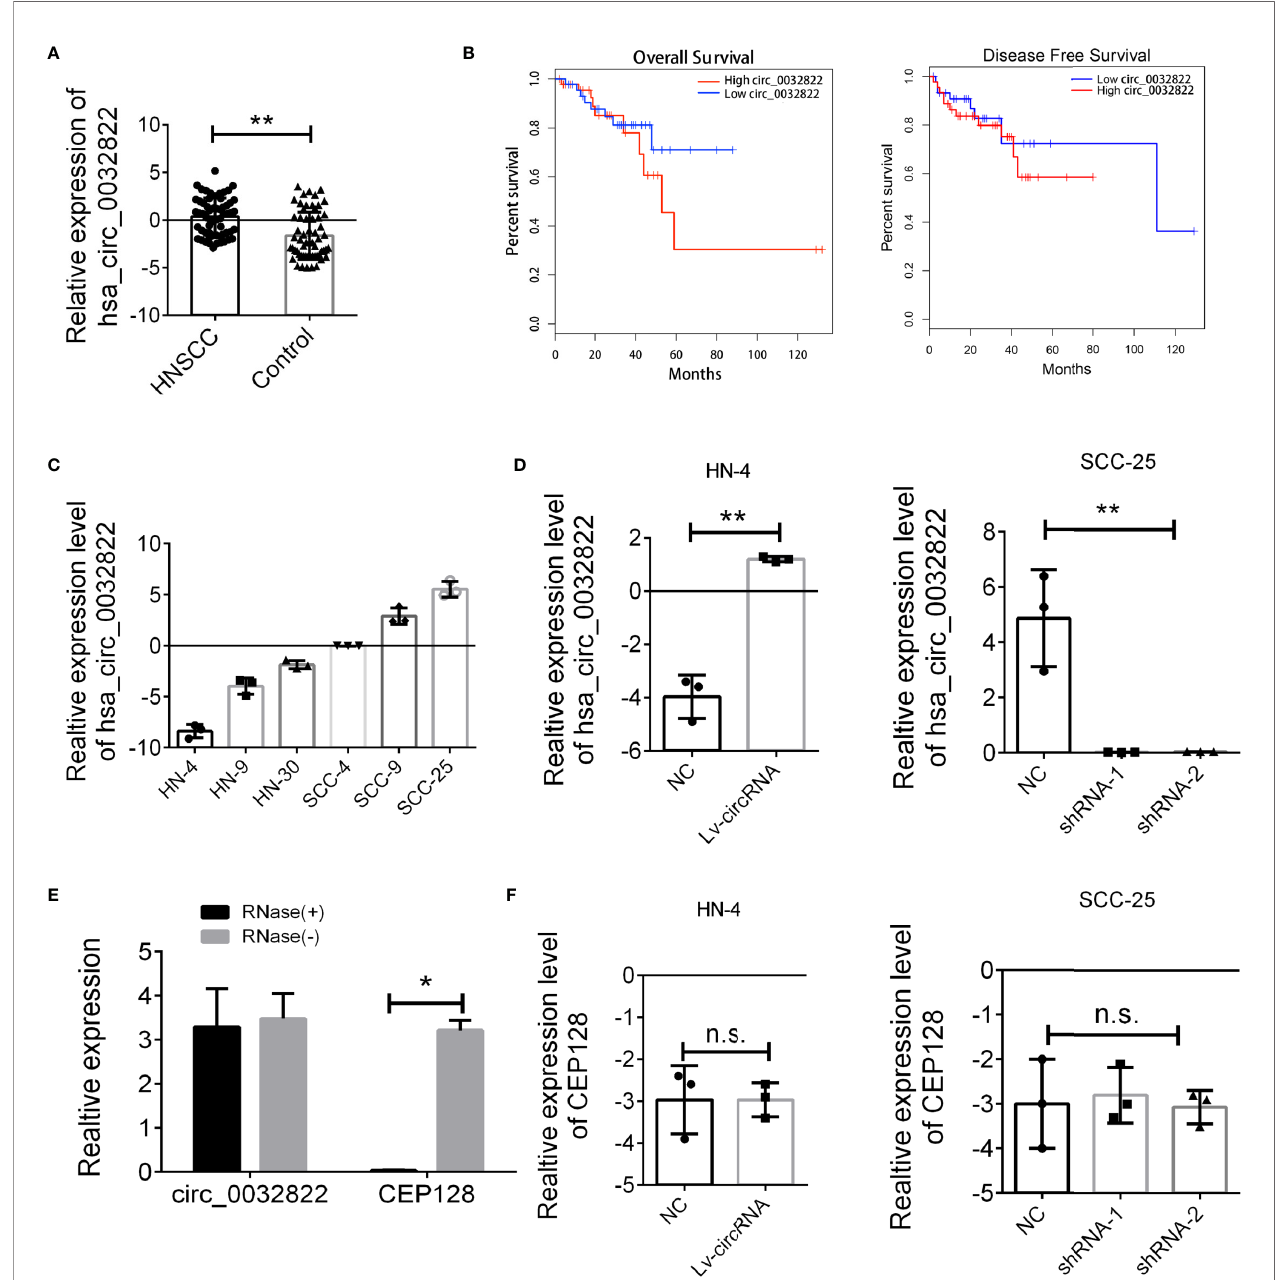
FIGURE 1 | Expression level of circ_0032822 in HNSCC tissues and cell lines. (A) The expression of circ_0032822 in HNSCC tissues (n=60) were detected by RT- PCR. (B) The overall survival and recurrence-free survival rates of HNSCC patients were compared between higher circ_0032822 and lower circ_0032822 groups. (C) The expression of circ_0032822 in HNSCC cell lines. (D) Ovexpression and knocking-down ef fi ciency in cell lines. (E) The PCR analysis con fi rmed that circ_0032822 resisted to RNase R digestion. (F) Expression of linear form of circ_0032822. Data were presented as plot of the mean with SEM, * indicated p < 0.05, ** indicated P < 0.01, n.s., no signi fi